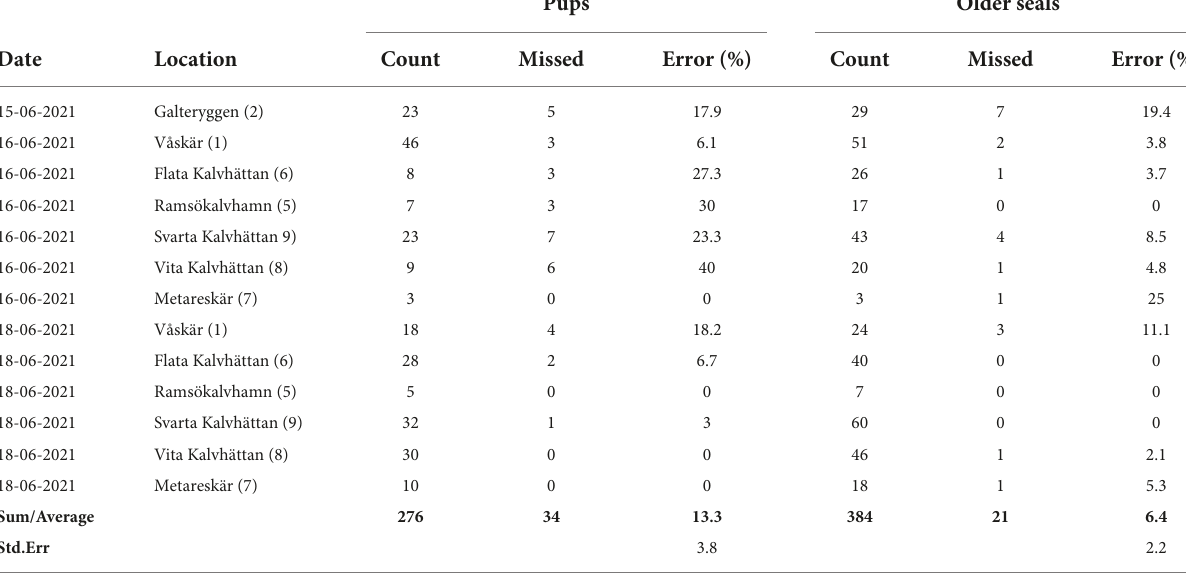
Inthecolumn“Location”thenameofthehaul-outskerriesandthenumberasindicatedonthemap( Figure2 )aregiven.Thecolumn“Pups”and“Older”givesthenumberofindividuals identifiedbythesoftware,andthenumberofindividualsmissed.Thecolumn“Error”isestimatedastheproportionofautomaticallydetectedpupstothehumanobserversestimate.N.b.